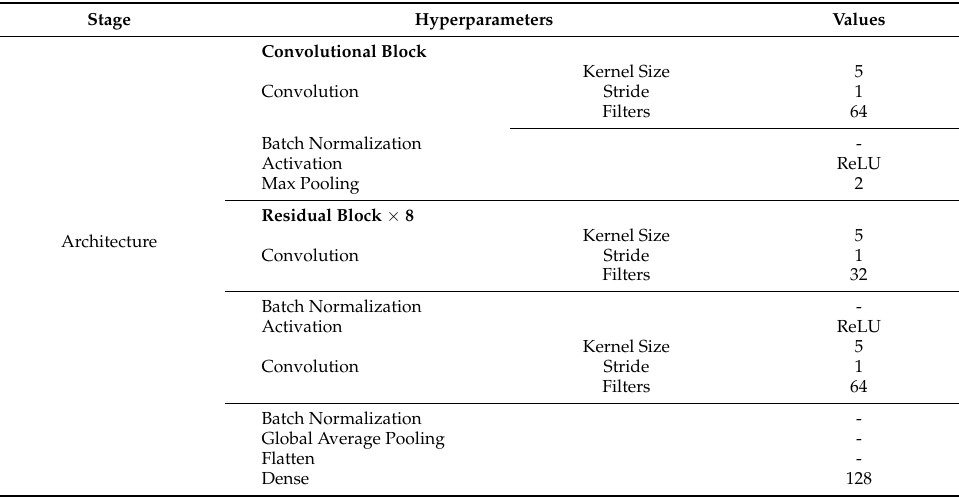
Table A3. The summary of hyperparameters for the 1D-ResNet network used in this